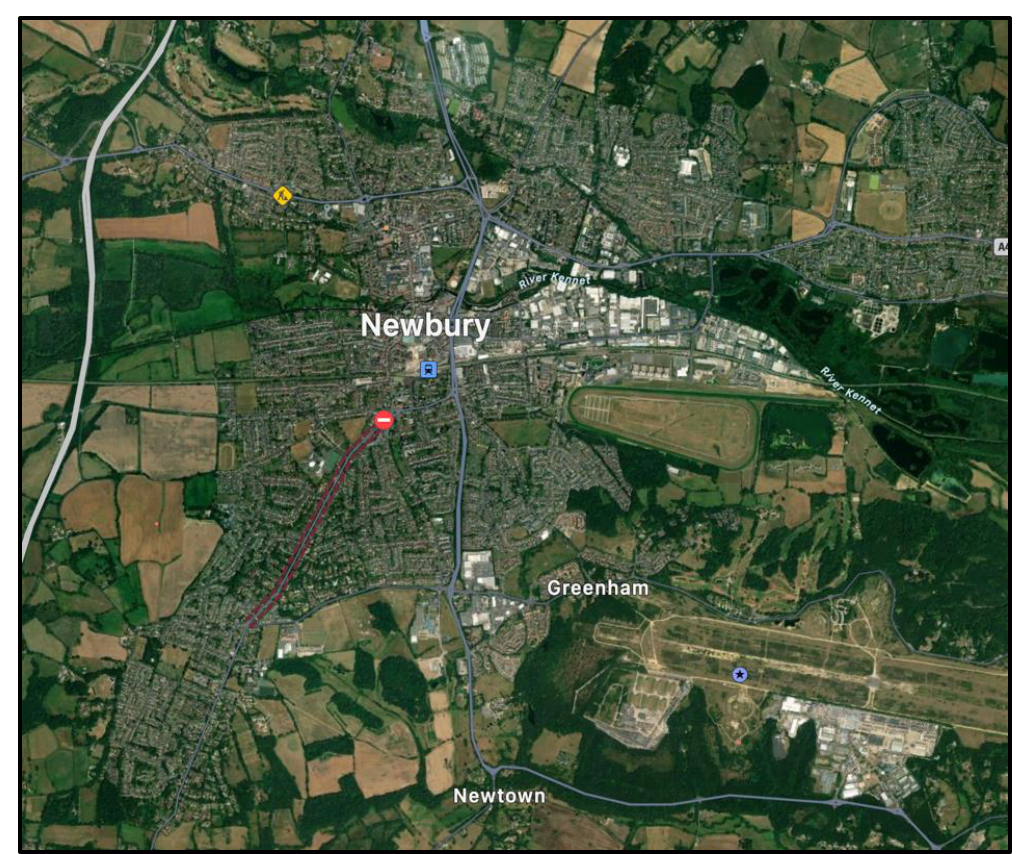
Figure 2. Map of Newbury, a typical UK town, with a mix of 1- and 2-storey buildings. (Source: Google Earth Maps).